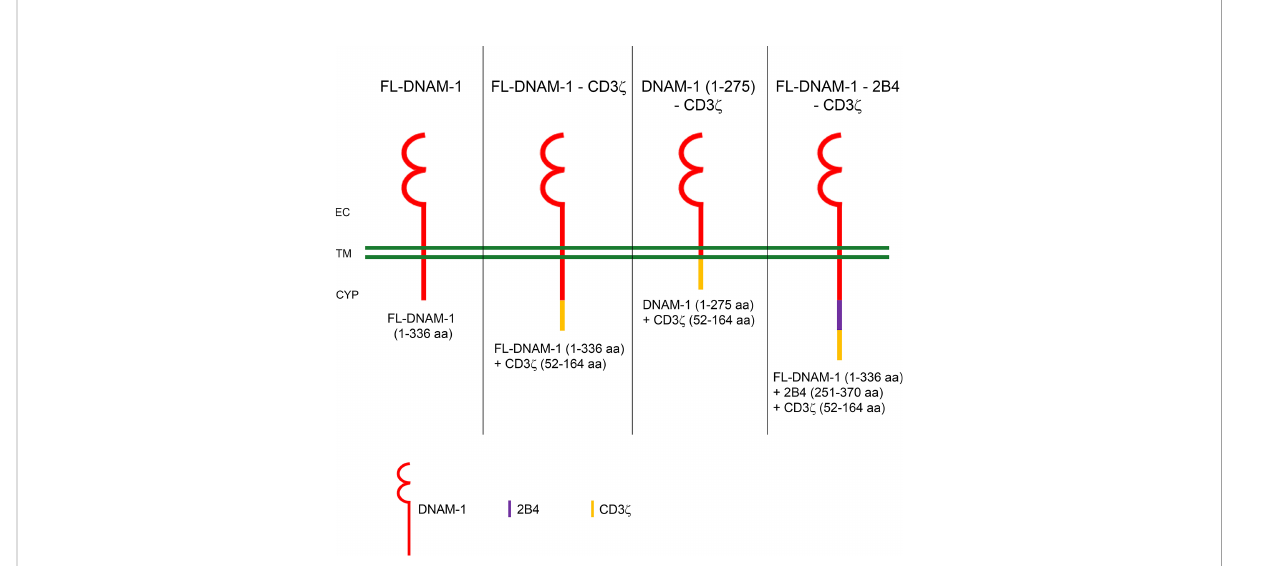
FIGURE 1 Schematic diagram of DNAM-1-based chimeric receptors. The amino acids (aa) sequences of DNAM-1 (red), CD3 z (yellow) and 2B4 (blue) are shown below each diagram of DNAM-1-based chimeric receptors. EC, extracellular; TM, transmembrane; CYP,